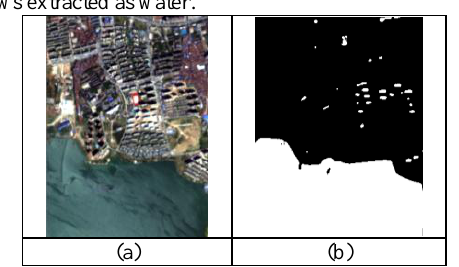
Figure 3. An example of shadows extracted as water original image; (b) correct water extraction result and shadows extracted as water A fragmentation index was defined to solve this problem. Water extraction results were binarized and divided into a regular grid. For binary water extraction results in every grid cell, similar connected cells, representing a domain were extracted. The number of domains with an area less than 1/n of the grid area was counted and denoted by numbersamll , and n was manually defined as 50. The total number of domains in that grid is denoted by numbertotal , and a fragmentation index in the grid area: